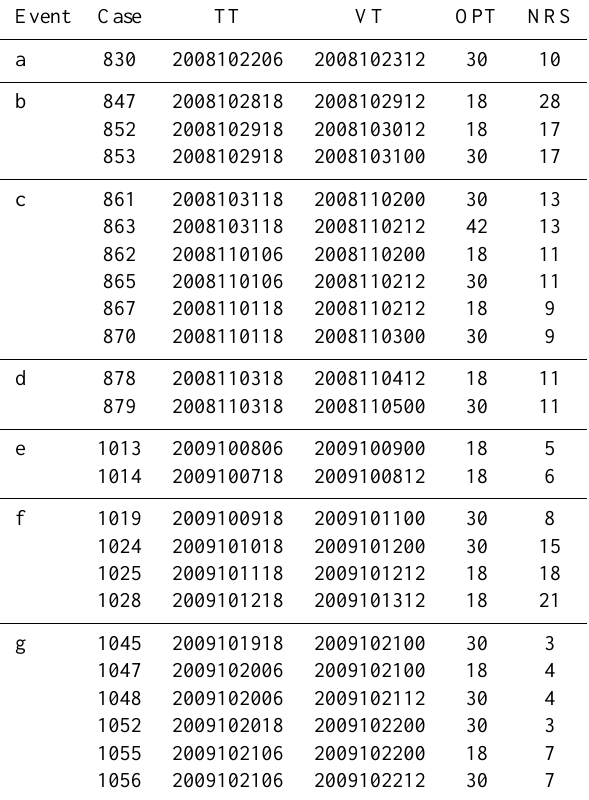
Table 1. Description of high-impact weather events for two-week periods of PREVIEW-DTS (2008) and MEDEX-DTS (2009) field campaigns. The optimization time (OPT) is the difference between verification time (VT) and target time (TT), and NRS is the number of targeted radiosondes deployed for each